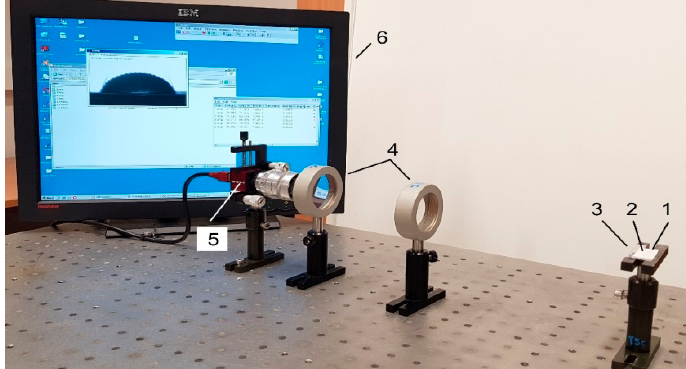
Figure 10. Experimental setup for contact angle measurement: 1, drop on the specimen; 2, analyzed coating; 3, specimen; 4, double convex lenses; 5, Guppy F-503 B&W CMOS camera; 6, computer system for analysis of the captured image.